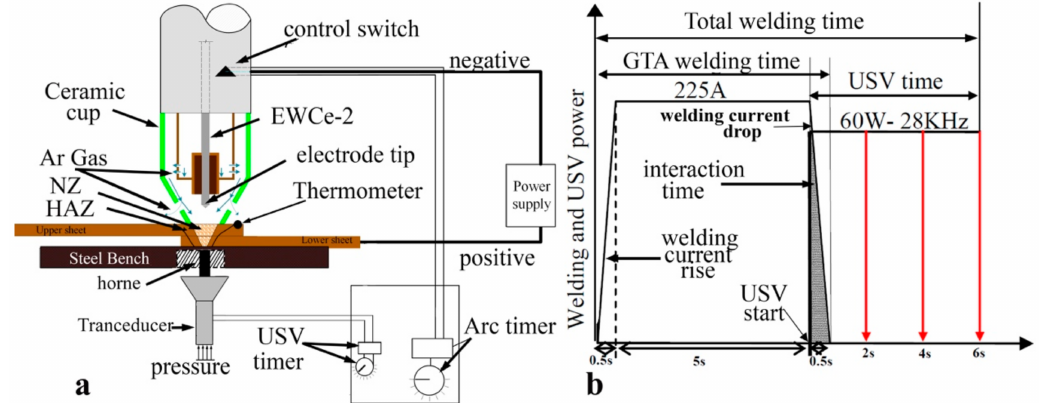
Figure 1. ( a ) Schematic diagram of GTA spot welding assisted with ultrasound; and ( b ) the power application cycle of the welding current and ultrasonic power